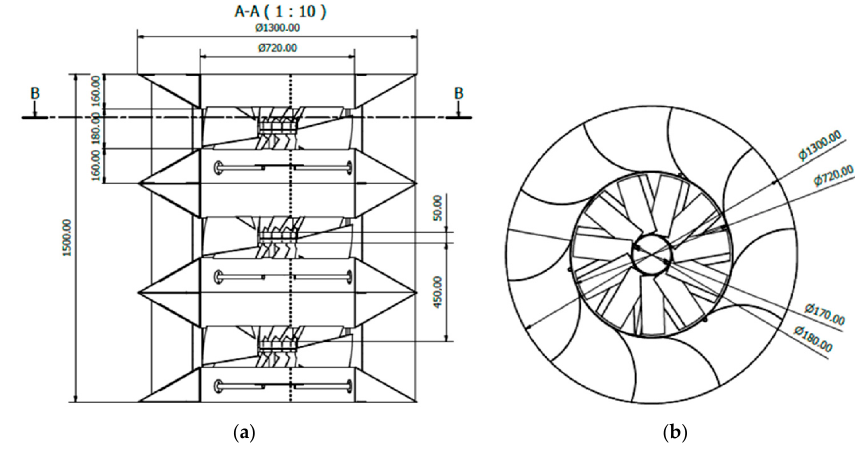
Figure 1. ( a ) The front view; ( b ) the top view of the basic geometry of a three-stage wind turbine KIONAS. Units in